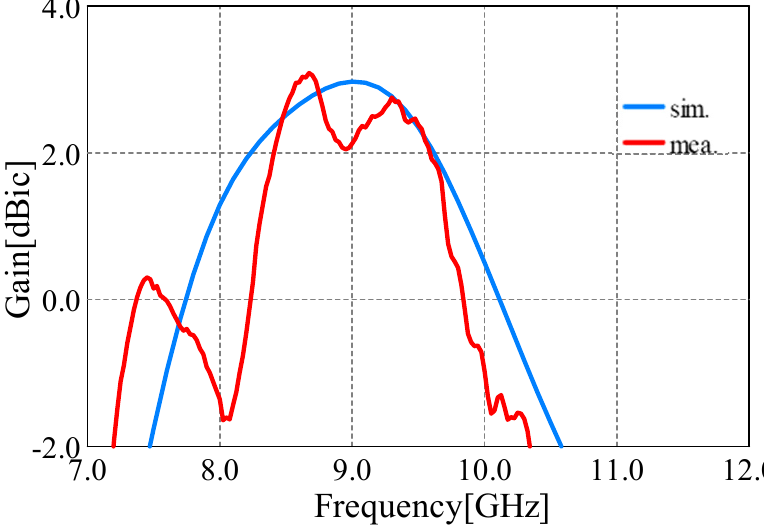
Figure 8. Measurement and simulation results for the frequency characteristics .